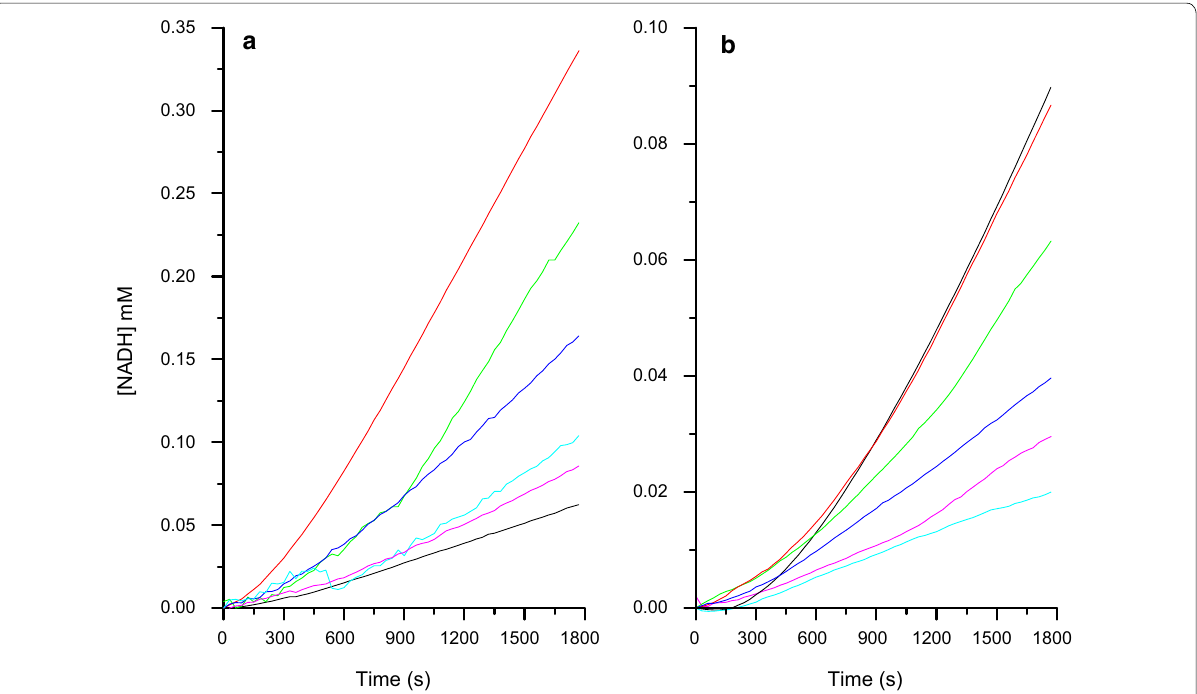
Fig. 5 a Kinetic contribution of xylonolactonase to the in vitro pathway to glycolate using xylonolactone as a substrate. The effect of Cc XylC concentration to the glycolate production was measured at pH 7.0 at 22 °C and the production of glycolate was followed through generation of NADH from the enzymatic oxidation step from glycolaldehyde to glycolate. The assays were performed in microtiterplates containing 100 μl: 50 mM Tris HCl pH 7.0, 10 mM MgCl 2 , 0.5 mM DTT, 2 mM NAD, 1 mM xylonolactone, 2 µg Cc XylD, 2 µg Ec YagE, and 2 µg Ec AldA. The amount of Cc XylC in the reaction was varied 0 µg (black line), 2 µg (magenta line), 4 µg (cyan line), 8 µg (blue line), 16 µg (green line) and 24 µg (red line). b Effect of d -xylonolactone concentration on production of glycolate. The efficiency of the 4-enzyme pathway was followed through generation of NADH from the enzymatic reduction step from glycolaldehyde to glycolate. The assays were performed in microtiterplates containing 100 μl: 50 mM